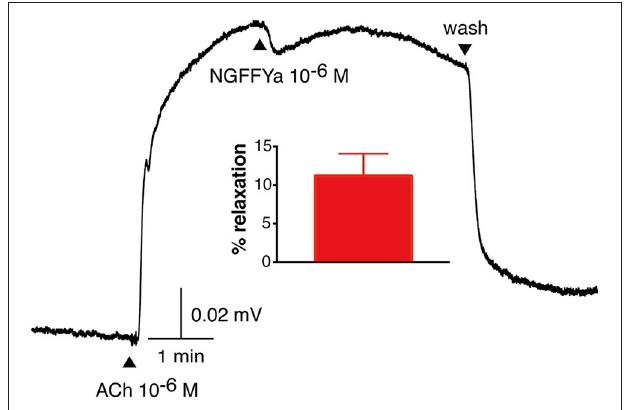
FIGURE 7 | NGFFYamide causes relaxation of in vitro acetylcholine-contracted apical muscle preparations from A. rubens . A representative recording is shown, with 10 − 6 M NGFFYamide causing transient partial reversal of the contracting action 10 − 6 M acetylcholine (ACh). Application of ACh and NGFFYamide are labeled with upward pointing arrowheads and washing of the preparation is labeled with a downward pointing arrowhead. The graph shows the mean ( ± s.e.m.) relaxant effect of NGFFYamide when tested at a concentration of 10 − 6 M ( n = 4).